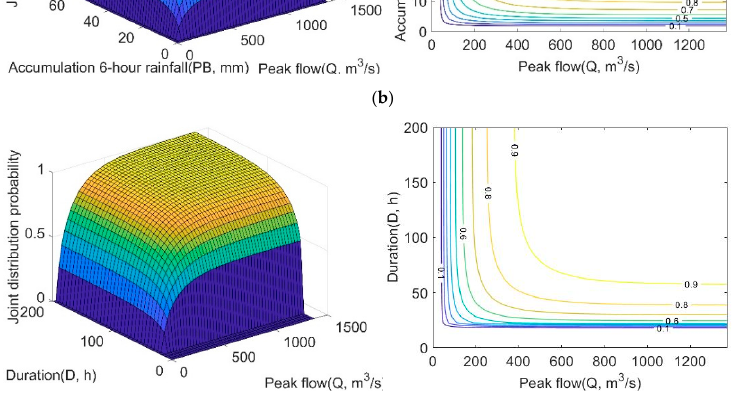
Table 8. Parameter θ of the Frank copula. Parameter